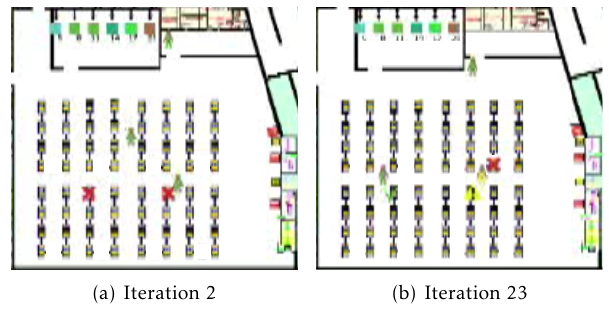
Figure 7. Illustration of simulation for two distinct iterations